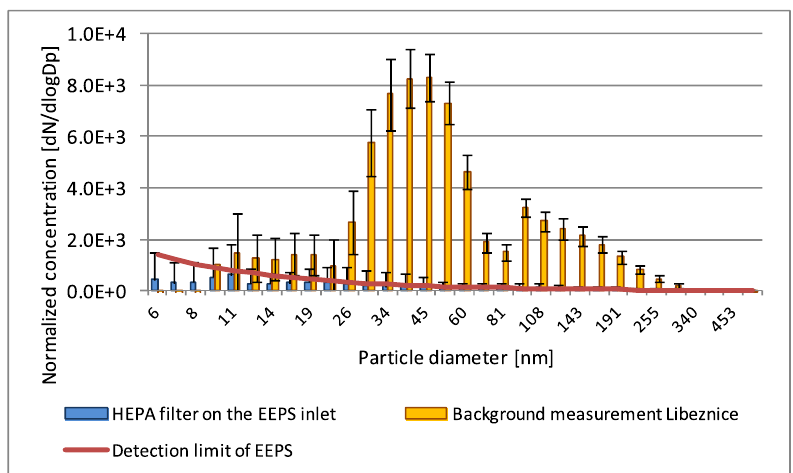
Figure 3. Comparison of manufacturer-supplied detection limit of EEPS, instrument electrometer noise (High-efficiency particulate arrestance (HEPA) filter on EEPS inlet) and the lowest measured number concentrations (Libeznice background) with standard deviations.